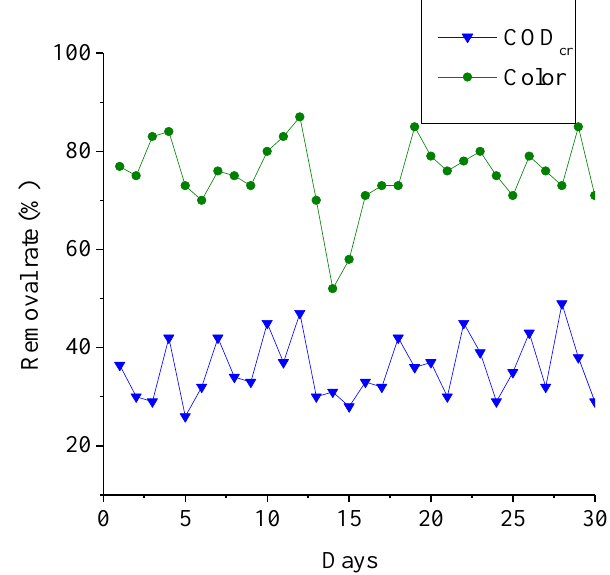
Figure 10. Removal rate of the COD cr and color in the second ozonation process .